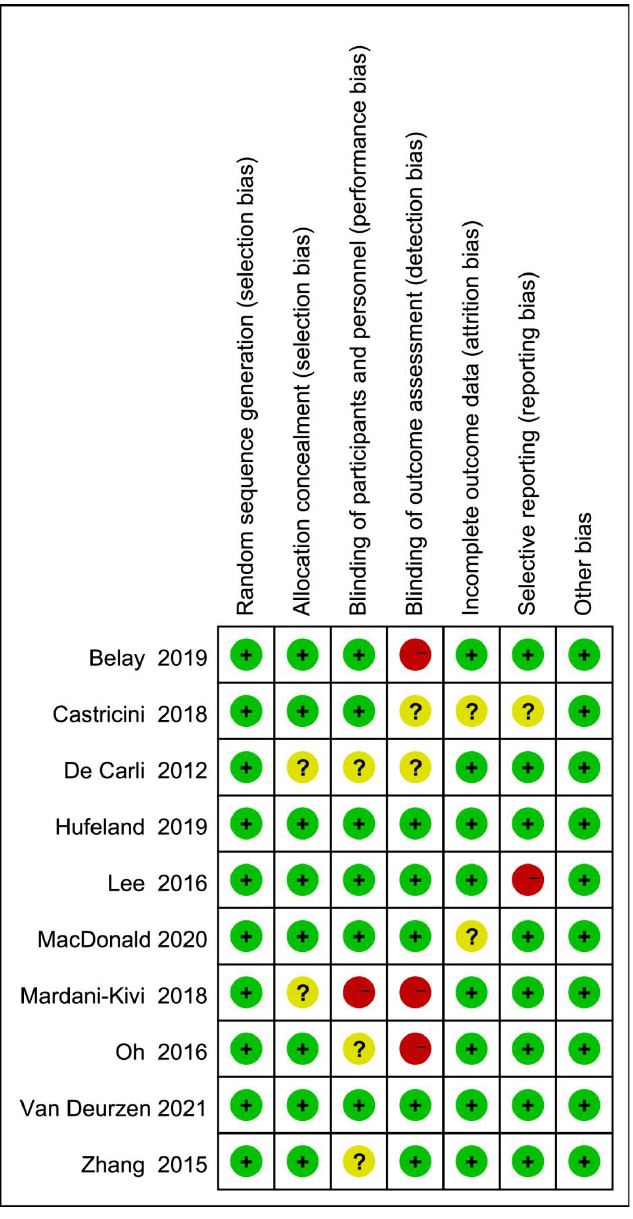
Figure 2. Risk of bias assessment of randomised controlled trials. Green means low risk. Red means high risk. Yellow means unclear risk.